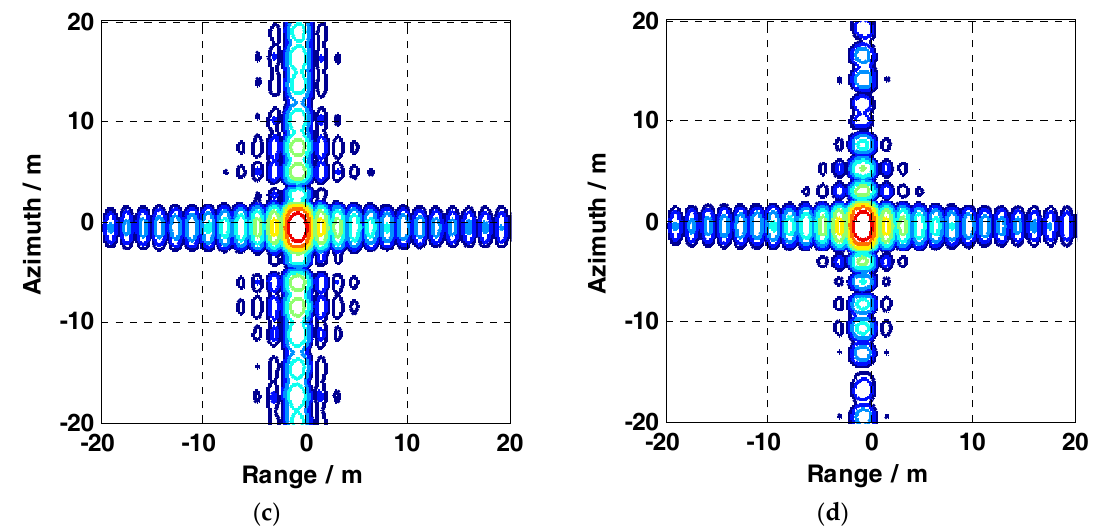
Figure 13. Target 5’s contours processed by ( a ) the conventional SAR imaging algorithm (CS algorithm), ( b ) MD algorithm, ( c ) PGA algorithm, and ( d ) BLUE algorithm, for strip ‐ map SAR data with burst ‐ like perturbation errors.